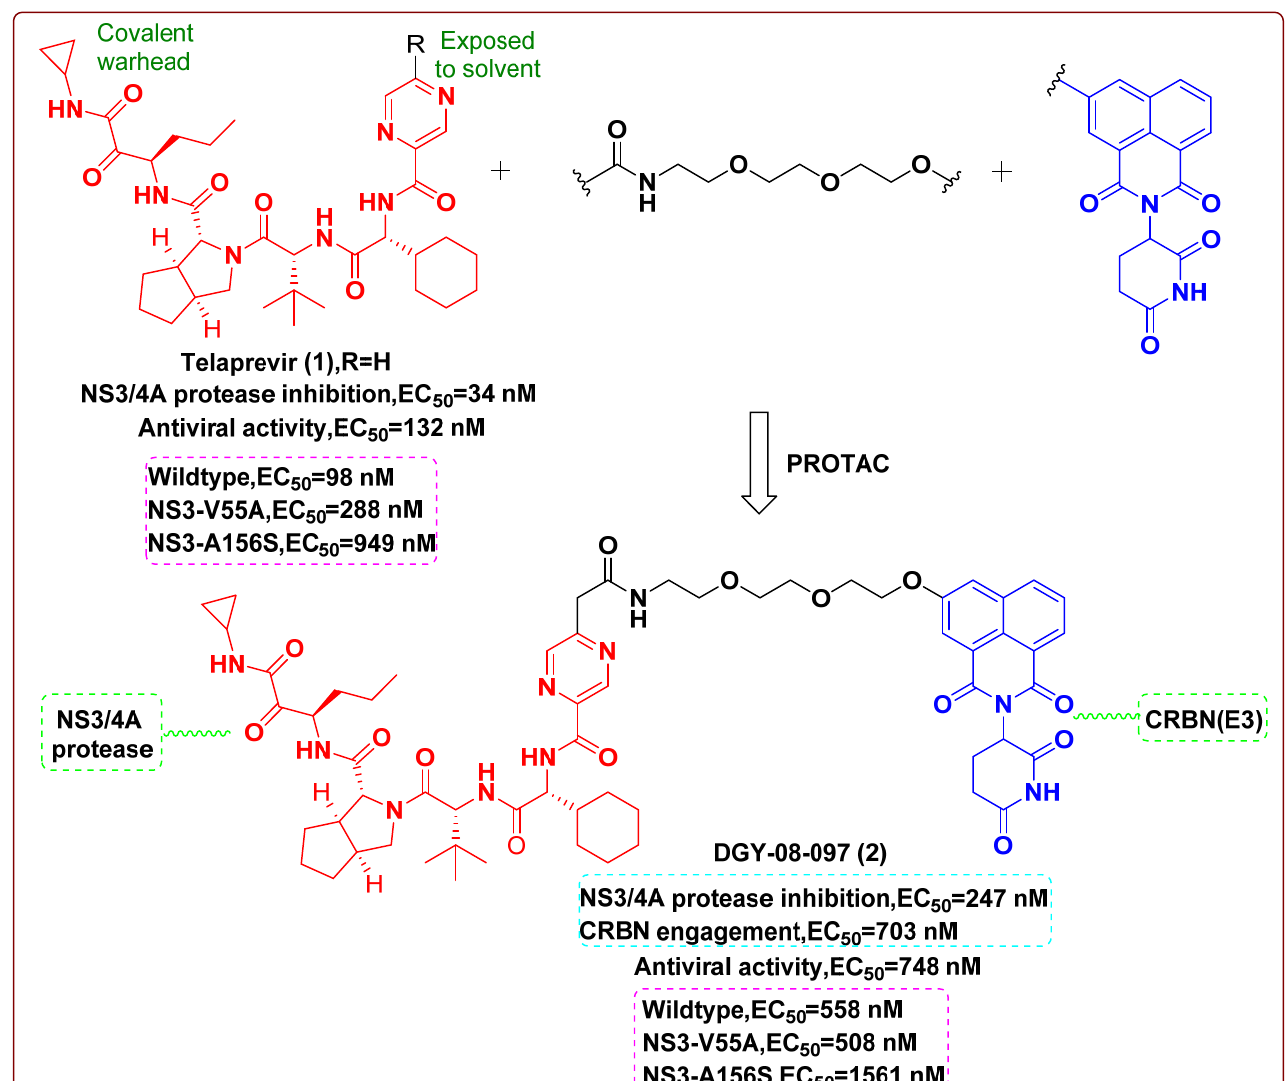
Figure 2. Chemical structures and inhibitory activities of telaprevir ( 1 ) and the degrader derivative DGY-08-097 ( 2 ) [16].